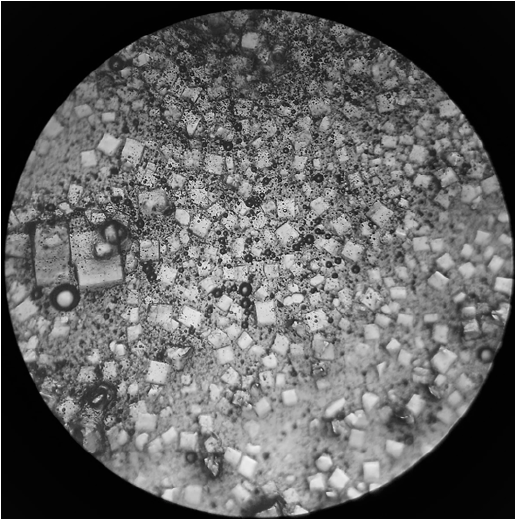
Figure 2. Sucrose crystals at the end of the process.